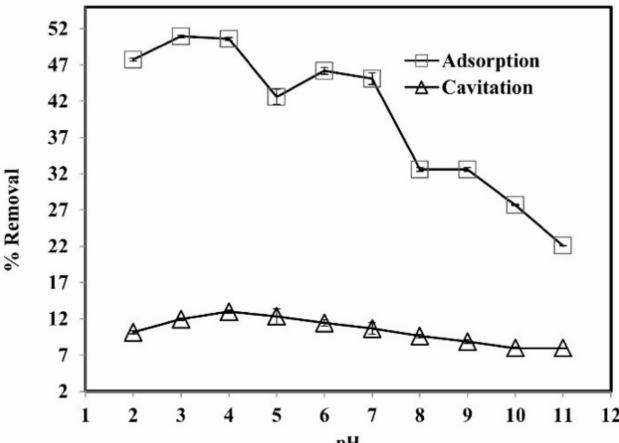
Figure 4. The effect of pH on the removal of phenol by adsorption and cavitation processes. Experi- mental conditions: phenol conc. = 25 mg L − 1 ; adsorbent dose = 800 mg L − 1 ; cavitation power = 80 W; temperature = 30 ± 2 ◦ C; time = 60